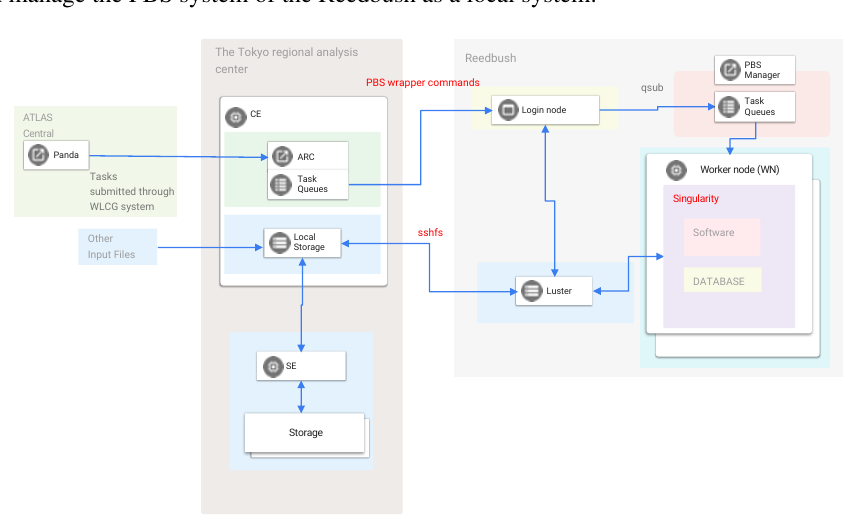
Figure 5. The schematic view of the system with